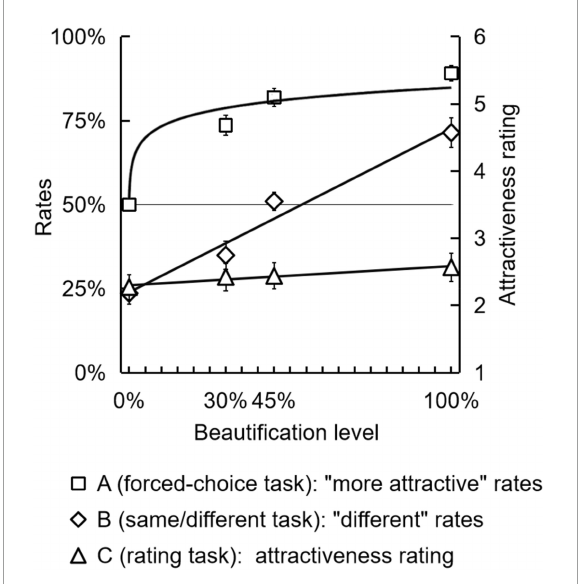
FIGURE5 Perceiving facial attractiveness change (Experiment 2). The “more attractive” rates in Experiment 2A, the “different” rates in Experiment 2B, and the attractiveness rating in Experiment 2C were shown. The black lines represented the fitted